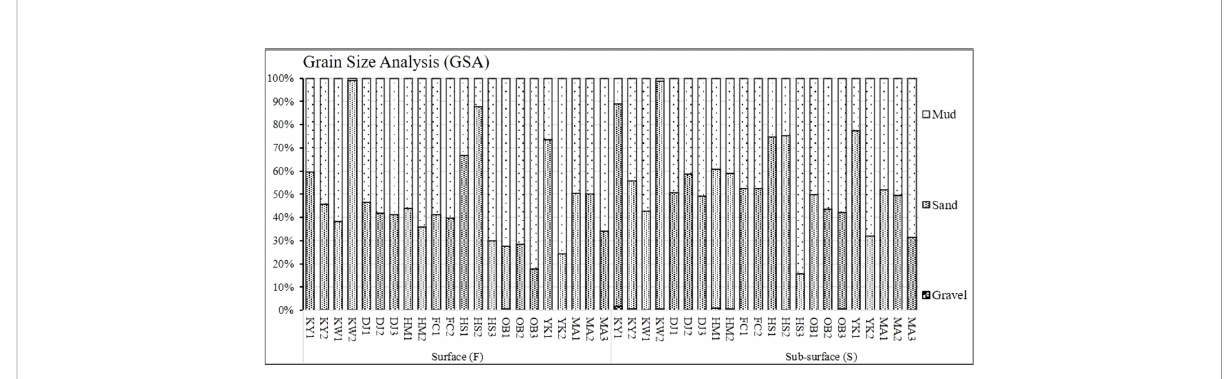
FIGURE 2 Granulometric analysis of surface and sub-surface sediments at Siangshan wetland, Hsinchu, Taiwan.